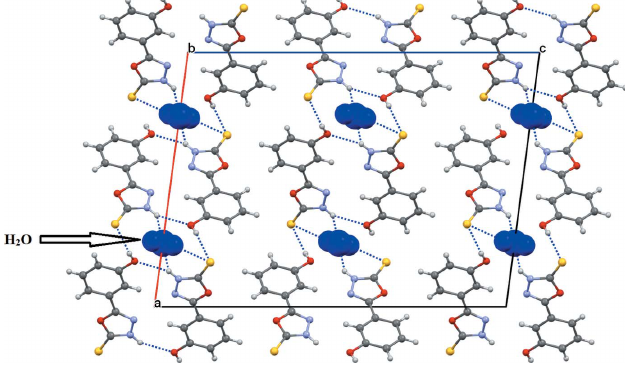
(16) and R 2 (6) graph-set motifs. 2 2